Question: Briefly state, in one sentence, what is plotted here.
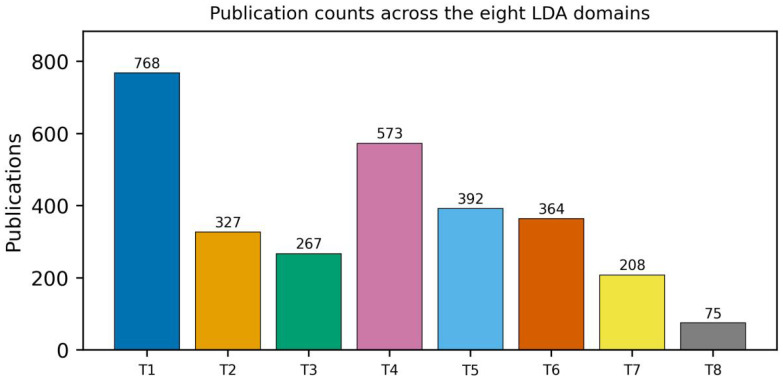
Answer: Publication counts across the eight LDA-defined thematic domains. Each publication was assigned to its dominant topic according to the highest posterior topic probability. Topic size represents the number of publications assigned to each thematic domain. The image illustrates the relative weight of the eight domains within the overall knowledge structure of host response-oriented sepsis research.